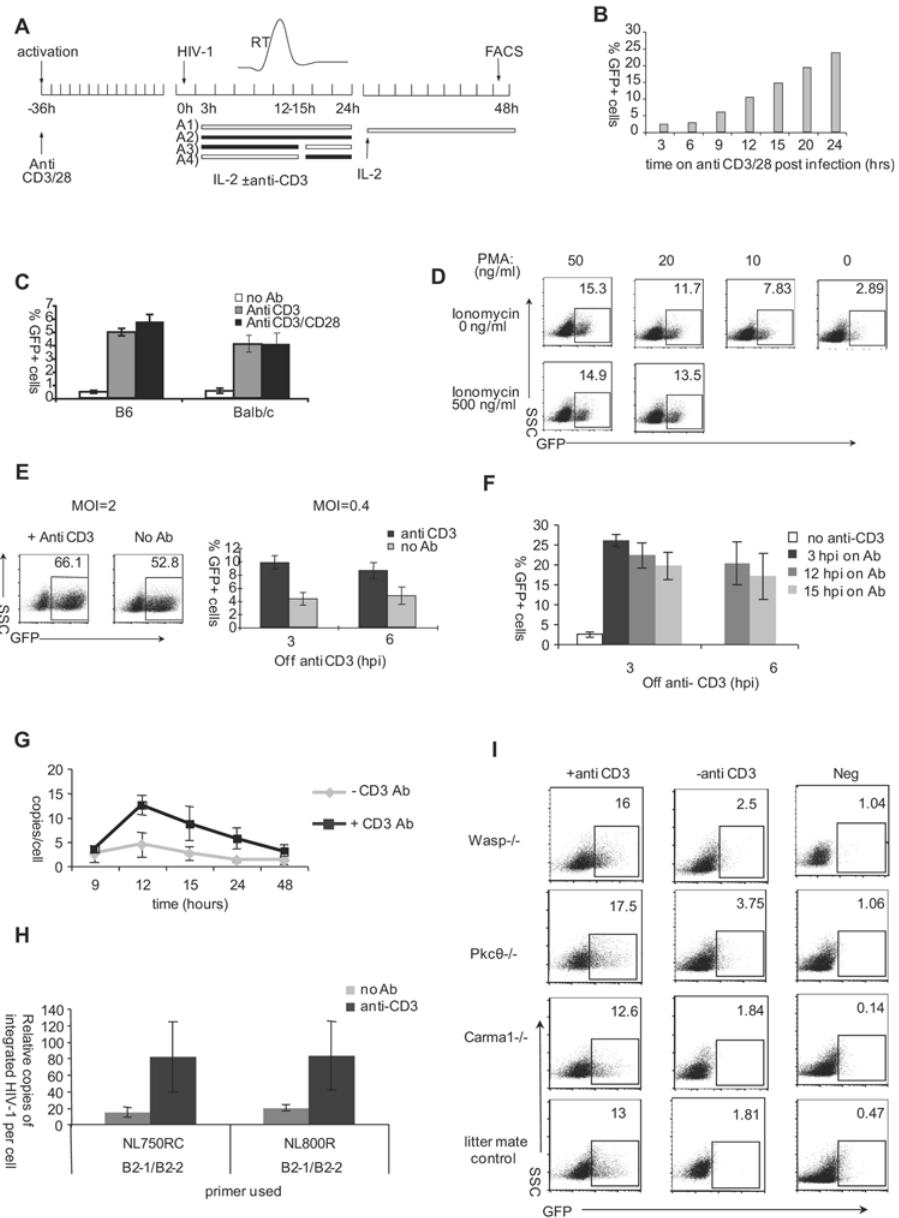
Figure 4. Signals from CD3 are important for HIV-1 infection in activated primary mouse T cells. The scheme for this experiment is shown in (A). MACS purified CD4 + CD25 2 T cells were activated by anti-CD3/28 for 36 h before spin-infection with VSVG-pseudotyped HIV-GFP. Infected cells were then subjected to different culture conditions. Between 3 and 24 h post infection, cells were cultured either A1) without anti-CD3; A2) with anti-CD3; A3) with anti-CD3 for a specified period of time before removal of anti-CD3; or A4) off anti-CD3 for a specified period of time before being placed on anti-CD3. Filled bars show the presence of anti-CD3 while open bars show the absence. At 24 h post infection, all cells were cultured with mIL-2 alone. Infection was assessed by GFP expression using flow cytometry at 48 h post-infection. (B) Activated CD4 + T cells from hCyclin T1 transgenic mice were subjected to the analysis shown in panel A condition 3. Infected mouse T cells were incubated on anti-CD3/28 antibody first and then removed from antibody at different time point as indicated on the x-axis. (C) Activated CD4 + T cells from wild type C57/BL6 (B6) and Balb/c mice were infected with HIV-CMV-GFP (VSVG) at MOI of 2. After infection, cells were provided with anti-CD3/28 (black bar), anti-CD3 (grey bar) or no antibody (open bar). (D) Analysis was as in panel A condition 2, except that PMA and ionomycin were used in place of anti-CD3. (E) Analysis was done as in panel B except that MLV was used. (F) Analysis as in panel A condition 4. At 3 h or 6 h post-infection, cells from hCyclin T1 mice were transferred to wells without anti-CD3. At 12 h or 15 h post-infection, these cells were transferred back to wells with anti-CD3. As controls, cells were treated under condition A1 and A2 at 3 h post infection. (G) CD4 + T cells from hCyclin T1 transgenic mice were infected with HIV- GFP (VSVG). Cells were taken off anti-CD3/28 at 3 h post-infection and transferred to wells without or with anti-CD3 as in panel A conditions A1 and A2. At different time points indicated on the X-axis, cells were collected and subjected to Real Time-PCR specific for U5-Gag as described in the legend to Figure 2B. (H) CD4 + T cells from hCyclin T1 transgenic mice were infected with HIV-GFP (VSVG). Cells were taken off anti-CD3/28 at 3 h post- infection and transferred to wells without or with anti-CD3 as in panel A conditions A1 and A2. At two days post infection, cells were collected and subjected to two–round PCRs, as described in Materials and Methods, to quantify the integrated proviruses. (I) CD4 + T cells from Wasp 2 / 2 , Pkc h 2 / 2 and Carma1 2 / 2 mice were activated with anti-CD3/28 in the presence of 100 U/ml mIL-2. After infection with HIV-CMV-GFP (VSVG), cells were provided with secondary anti-CD3 or no antibody as shown as in panel A conditions 1 and 2. All data represented three independent experiments. doi:10.1371/journal.pone.0002035.g004 PLoS ONE |